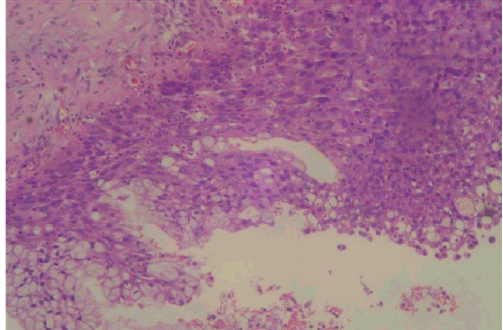
Figure 1A – Well-differentiated squamous cell carcinoma associated with nests of large cells with abundant basophilic cytoplasm and basally located nuclei, tending to assume a glandular arrangement (hematoxylin and eosin; original magnification, 100x).